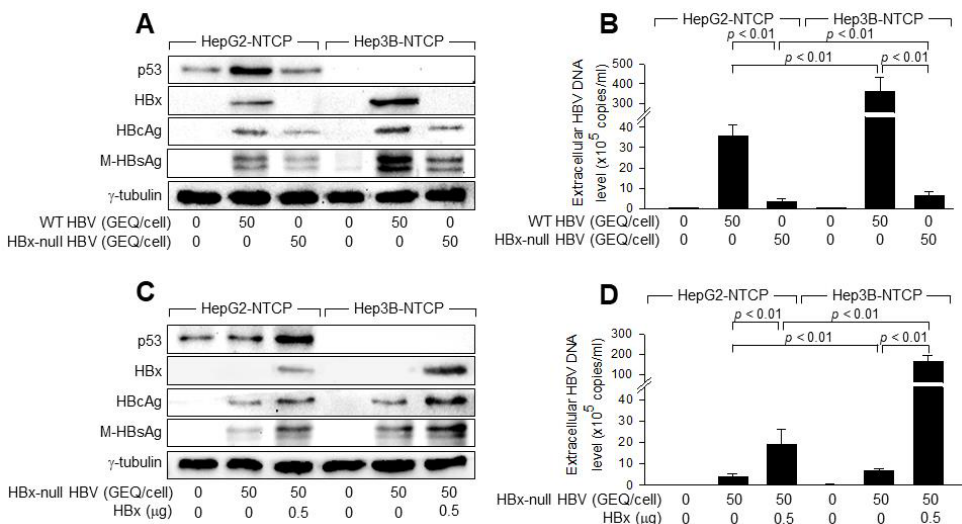
Figure 4. p53 prevents HBx from stimulating HBV replication in human hepatoma cells. ( A ) HepG2-NTCP and Hep3B-NTCP cells were either mock-infected or infected with WT HBV or HBx-null HBV at 50 GEQ/cell for four days, followed by Western blotting. ( B ) Levels of HBV particles released from the cells prepared in ( A ) were determined by qPCR ( n = 7). ( C ) HepG2-NTCP and Hep3B-NTCP cells were transfected with either an empty vector or HBx expression plasmid for 24 h and either mock-infected or infected with HBx-null HBV at 50 GEQ/cell for four days, followed by Western blotting. ( D ) Levels of HBV particles released from the cells prepared in ( C ) were determined by qPCR ( n = 5).